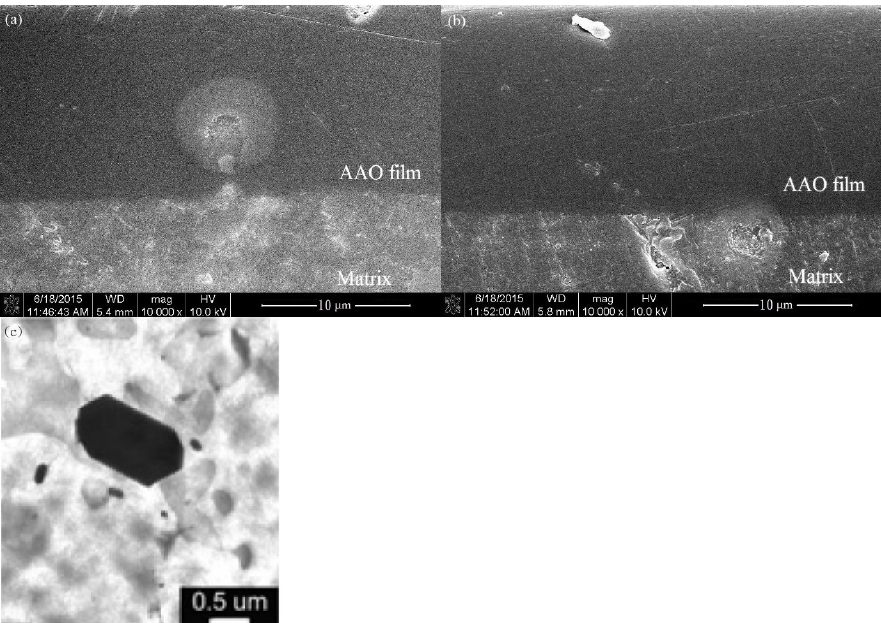
Figure 11. SEM photos show the cross-section of deposited anodized/sealed films on ( a ) T6 sample; ( b ) CFT6a sample; and ( c ) anodized/sealed 6063-T6 samples [27].